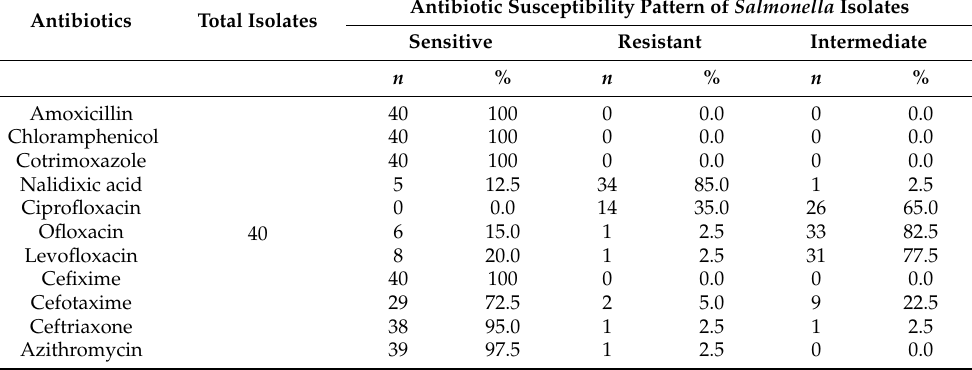
Table 2. Antibiotic susceptibility pattern of Salmonella isolates.